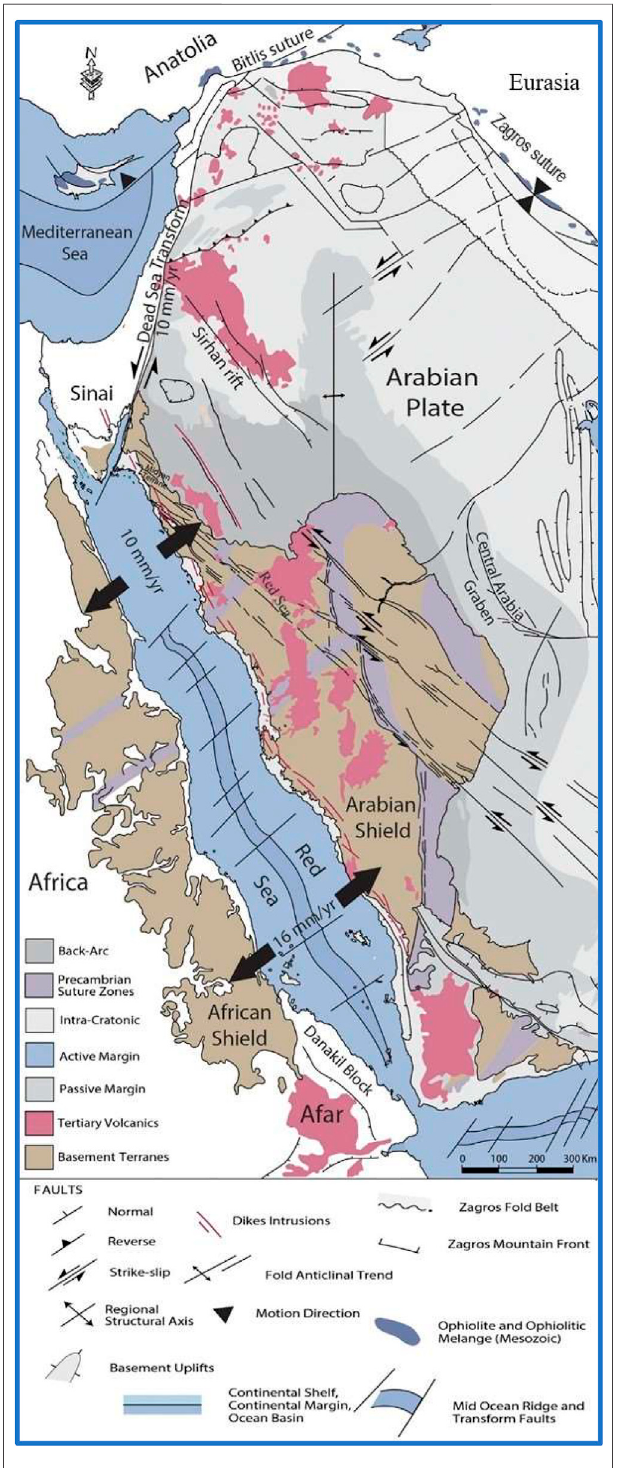
FIGURE 3 | Geological and tectonic elements map of the Arabian Plate and surrounding regions modi fi ed after Sharland et al. (2001). Geodetic observations estimate extensional rates along the Red Sea between 7 and 15 mm/year from north tosouth, and between 15 and 19 mm/year from west to east, left lateral slip rates along the southern Dead Sea Transform in